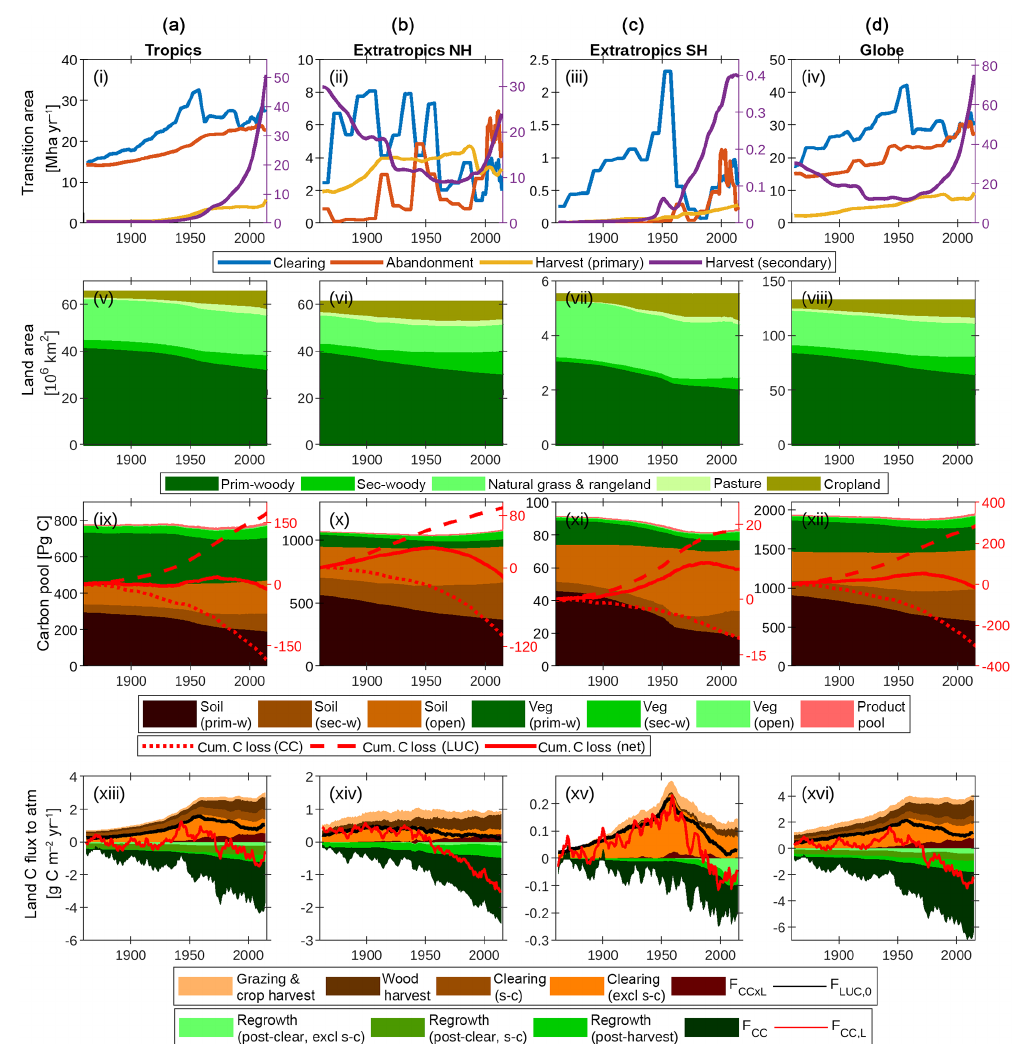
Figure 7. The global terrestrial carbon balance (1860–2016) and its partitioning, as influenced by LUC, land management, CO 2 and climate. Columns refer to (a) the tropics ( − 30 to 30 ◦ ), (b) extratropics of the Northern Hemisphere (NH; > 30 ◦ ), (c) extratropics of the Southern Hemisphere (SH; < 30 ◦ ) and (d) the globe, excluding permanent ice. Rows refer to the same quantities as in Fig. 6. A 5-year smoothing is applied for